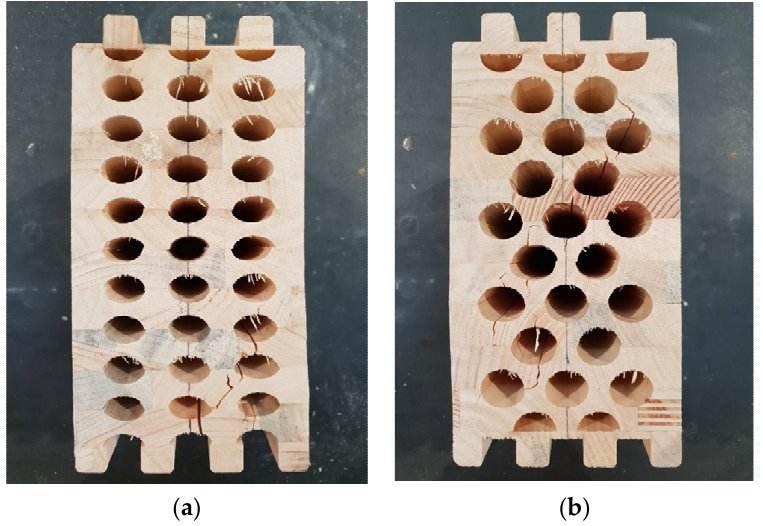
Figure 22. Samples with elliptical ( a ) and circular ( b ) cavities after experimental test of compressive strength perpendicular to the grain in the direction of a weaker axis.